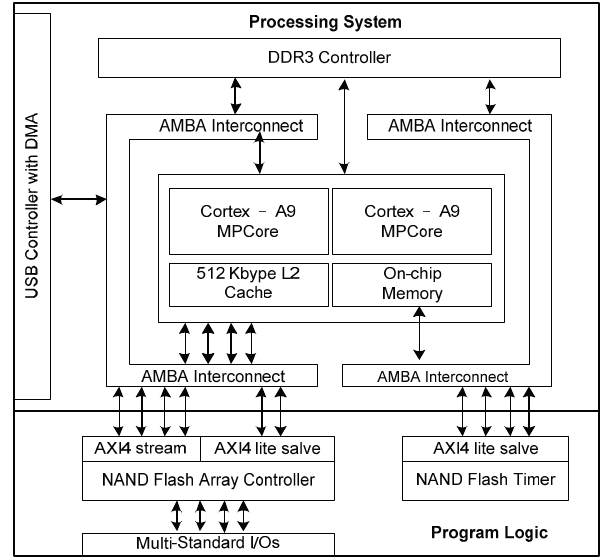
Figure 9. The firmware architecture of the experimental